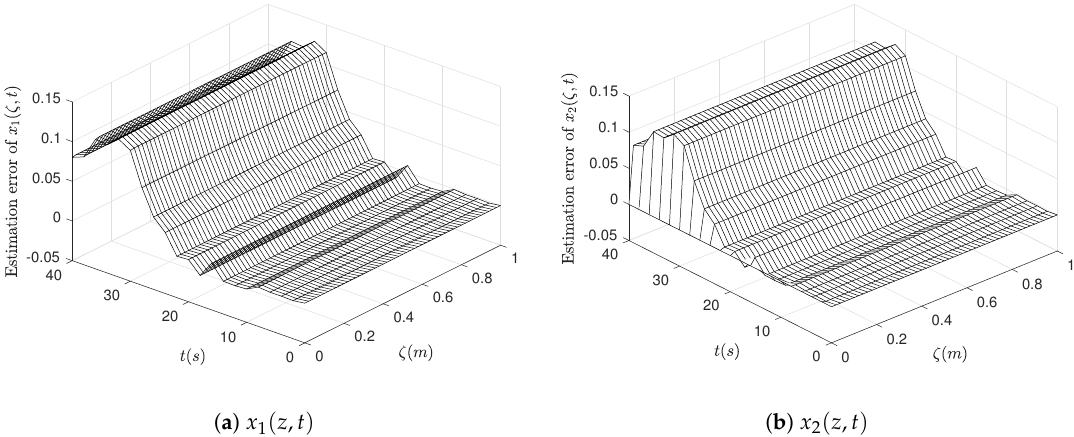
Figure 12. State estimation errors of the wave system.